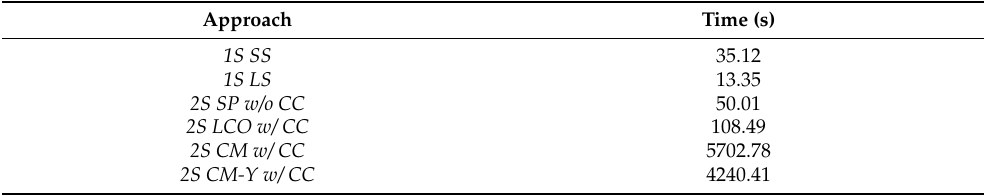
Table 5. Computational time (feed-forward time) of the used models with two warm-up predictions and six timed predictions of overview images. Tested on a GeForce RTX 3090 GPU and a Ryzen 5950X